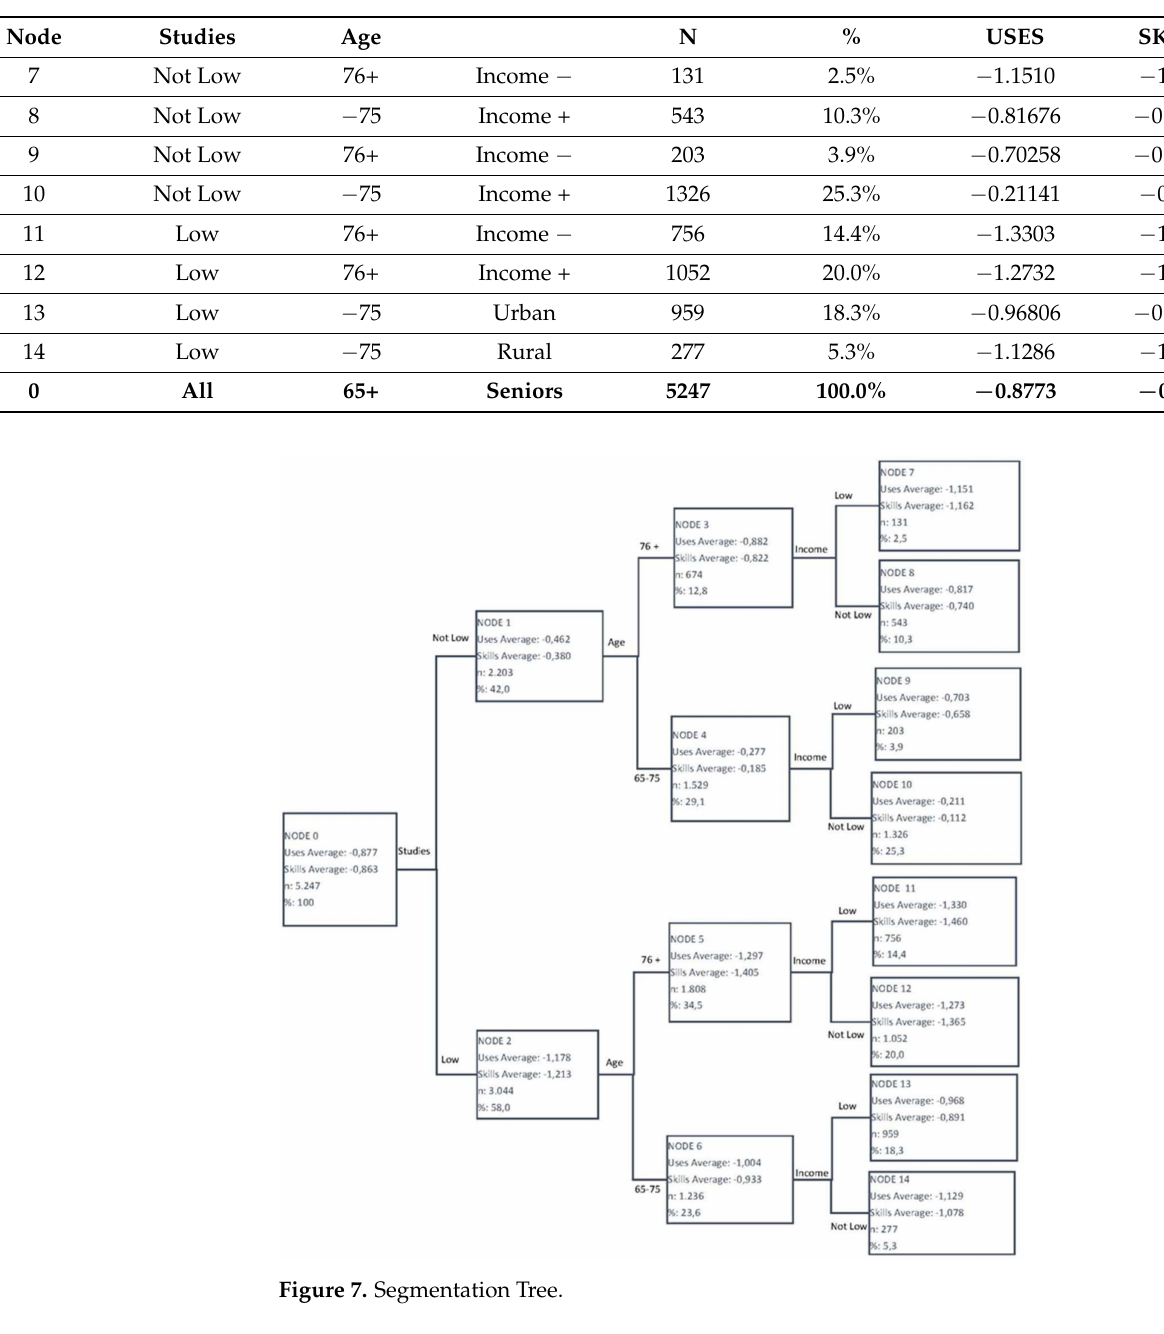
Table 10. Chaid segmentation summary.